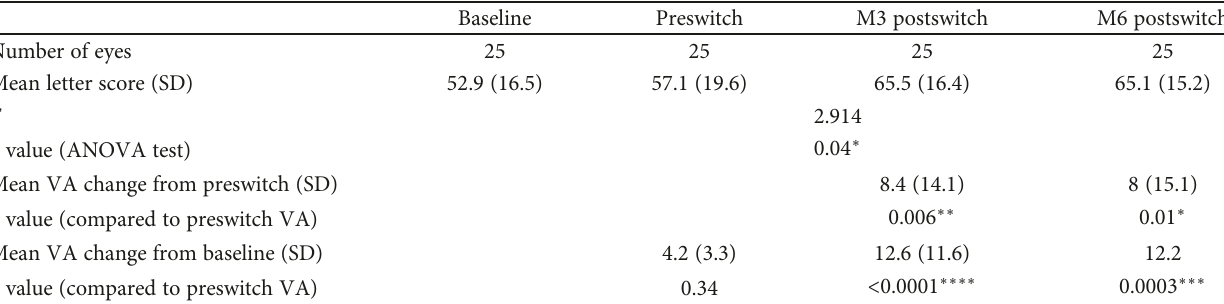
Table 2: Functional outcomes: visual acuity before any intravitreal injection (baseline) and before and after switch to a fl ibercept at M3 and